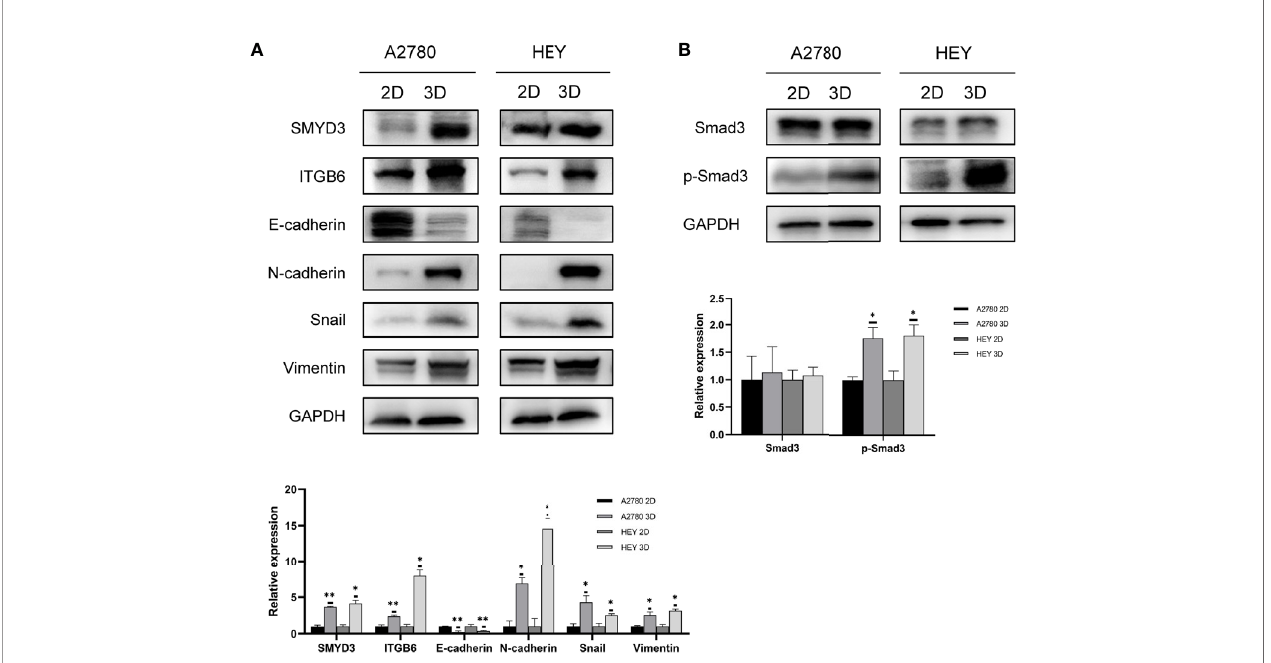
FIGURE 1 | EMT along with SMYD3 and ITGB6 upregulation is promoted during ovarian cancer cell spheroid formation. (A) The expression levels of SMYD3, ITGB6, N-cadherin, Snail, Vimentin and E-cadherin in 2D- and 3D-cultured HEY and A2780 cells were evaluated by western blot analysis. (B) The phosphorylation level of Smad3 in 2D- and 3D-cultured HEY and A2780 cells was evaluated by western blot analysis. In the histogram of the western blot quanti fi cation, “ * ” refers to p < 0.05 and “ ** ” refers to p <